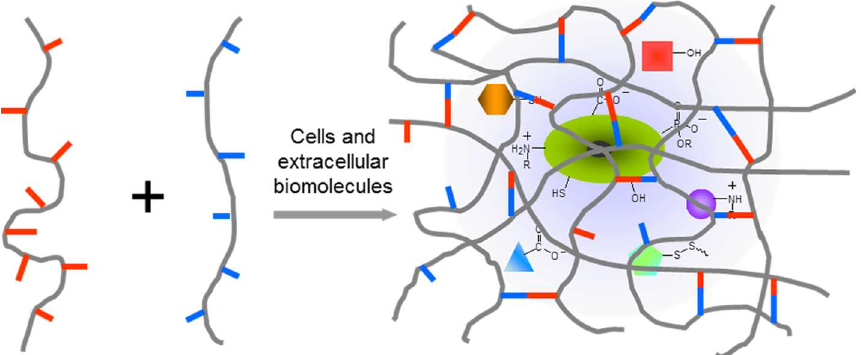
Figure 1. In situ crosslinking of hydrogels in the presence of the biological complex including cells, extracellular components, and therapeutic agents. Hydrogel networks should form upon chemoselective interactions between polymer precursors in order to minimize the disturbance to the biological systems under